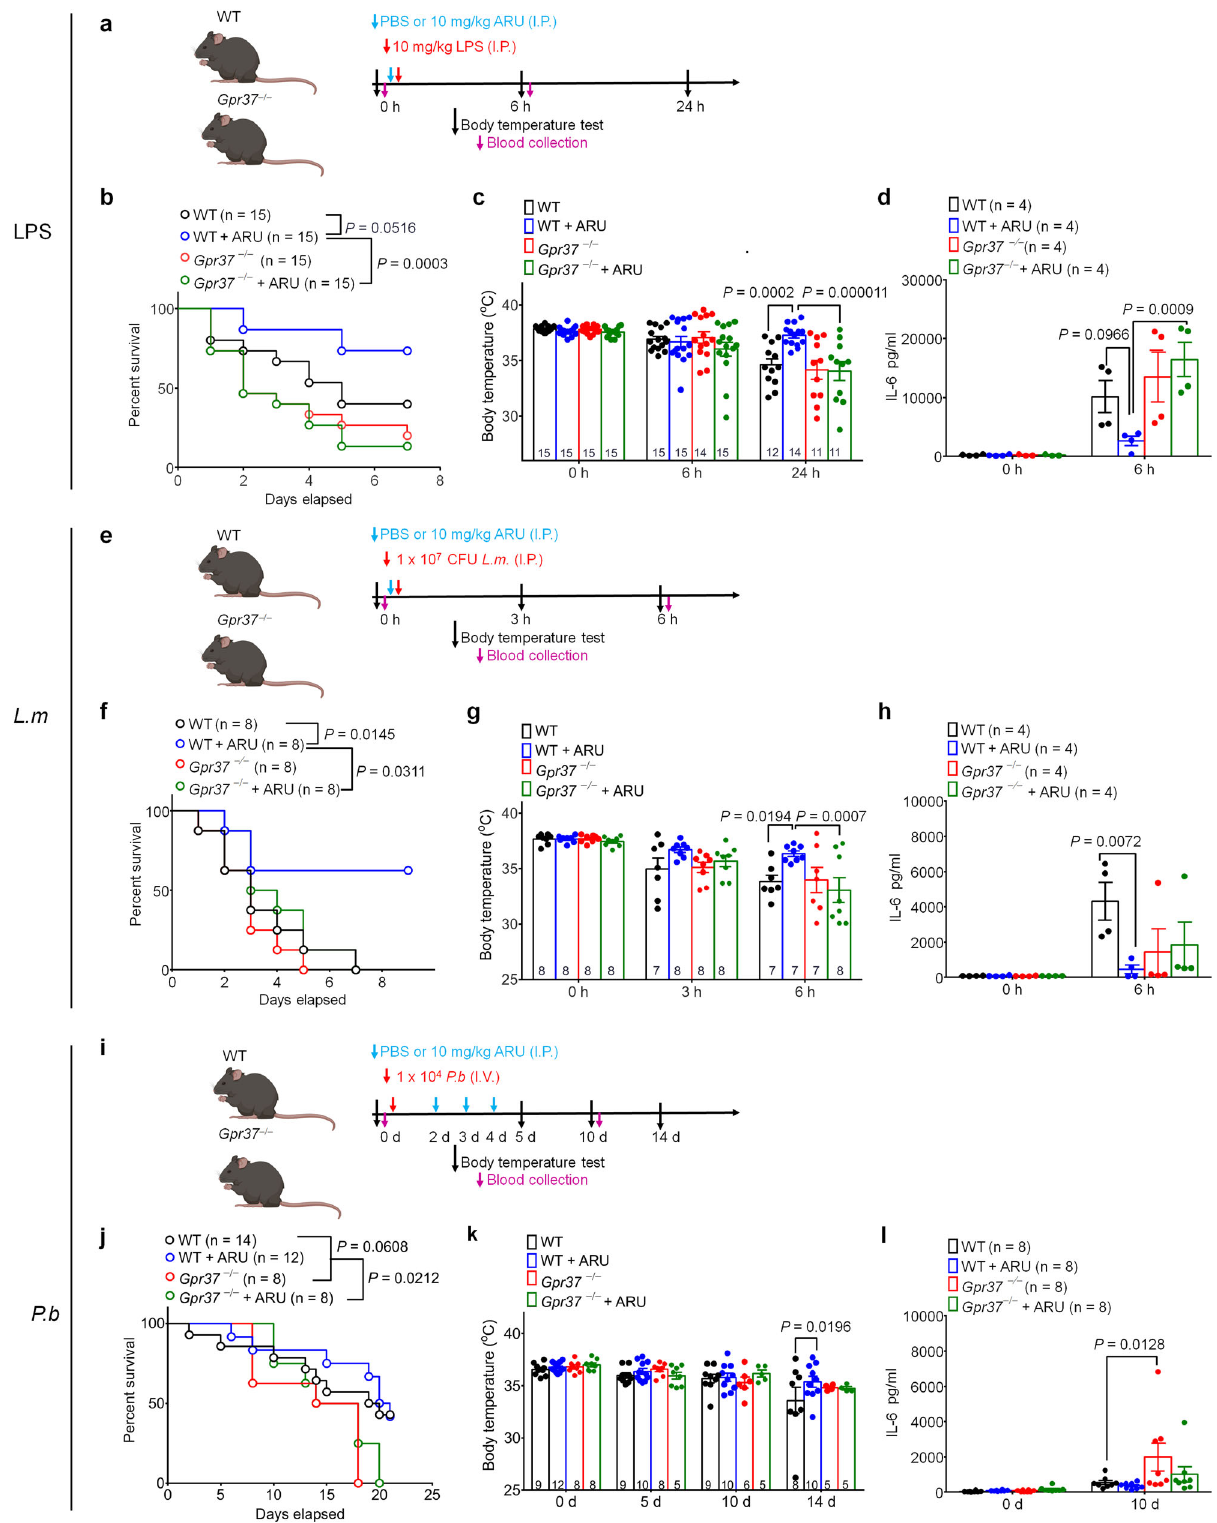
sensitivity at baselines. Remarkably, mechanical allodynia recovered by day 14 in WT mice, but remained unresolved in Gpr37 − / − mice (Fig. 8d). Finally, the adoptive transfer of ARU- primed pM Φ also reversed L.m .-induced mechanical allodynia in Gpr37 − / − mice (Fig. 8g, h), and intraplantar injection of ARU